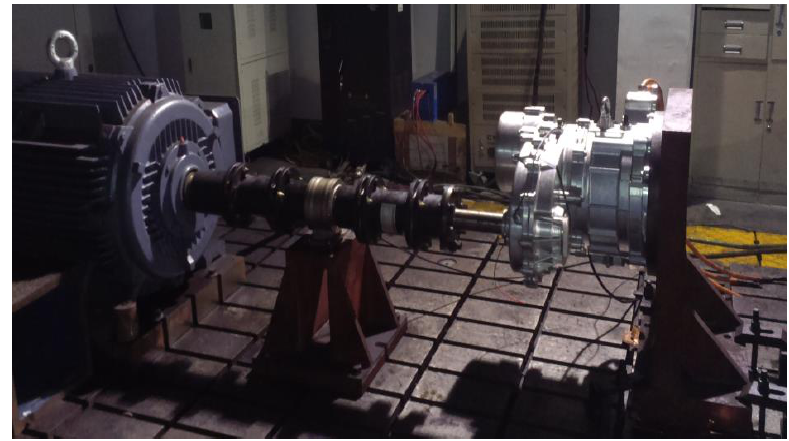
Figure 8. Dyne-test bench for the i-KERD system functional testing.